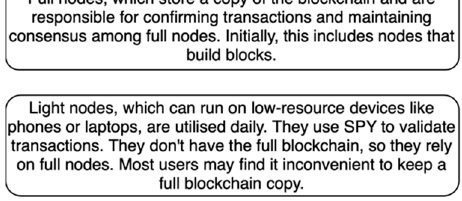
Figure 7. Blockchain Ownership. 4.3. Blockchain—Internet of Things for Smart Home and Other Appliances